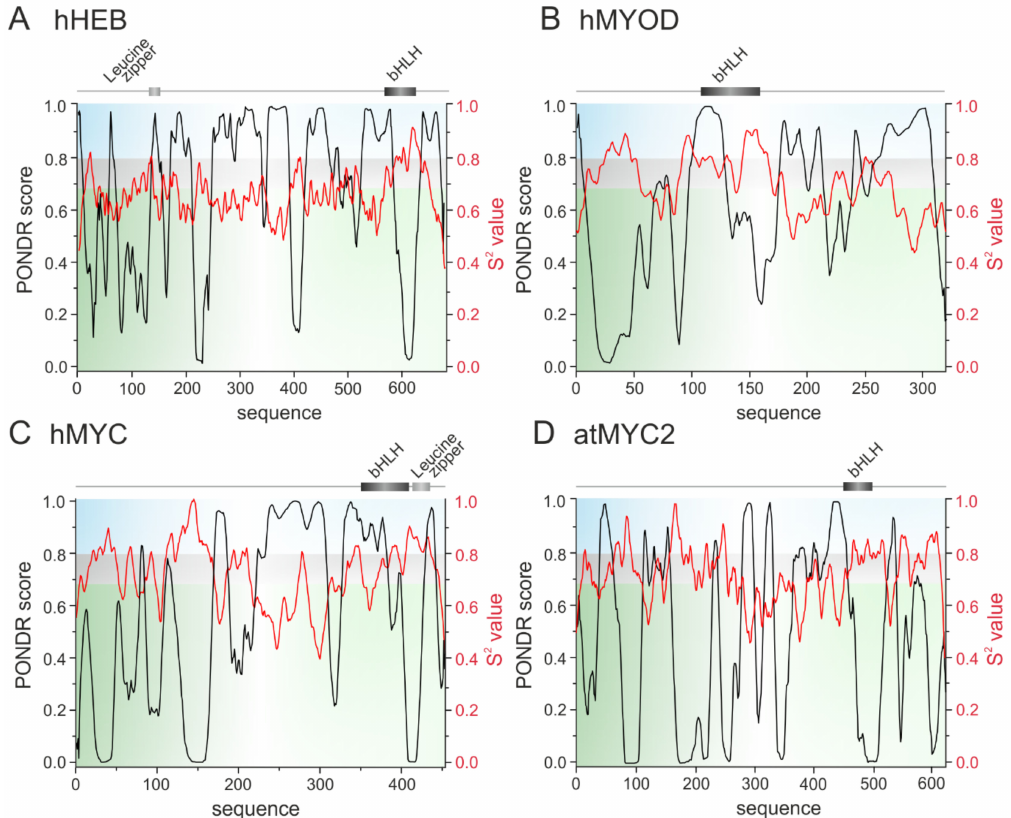
Figure 1. Prediction of intrinsically disordered regions. The top panel presents the domain structure of the analyzed bHLH proteins. Dark grey rectangle indicates the position of bHLH domain, the light grey Leucine zipper. The bottom panel presents a prediction of intrinsically disordered and flexible regions based on the amino acid sequence of proteins. Prediction were performed using PONDR-VLXT (left Y axis) and DynaMine (right Y axis) software. For PONDR prediction, a score above 0.5 indicates disorder. For DynaMine, a S 2 value above 0.8 (blue zone) indicates rigid conformation, 0.69-0.8 (grey zone) is context dependent and a value below 0.69 (green zone) indicates flexible conformation. ( A ) class I human HEB [Q99081], ( B ) class II human MYOD [P15172], ( C ) class III human MYC [P01106-2] and ( D ) Arabidopsis thaliana MYC2